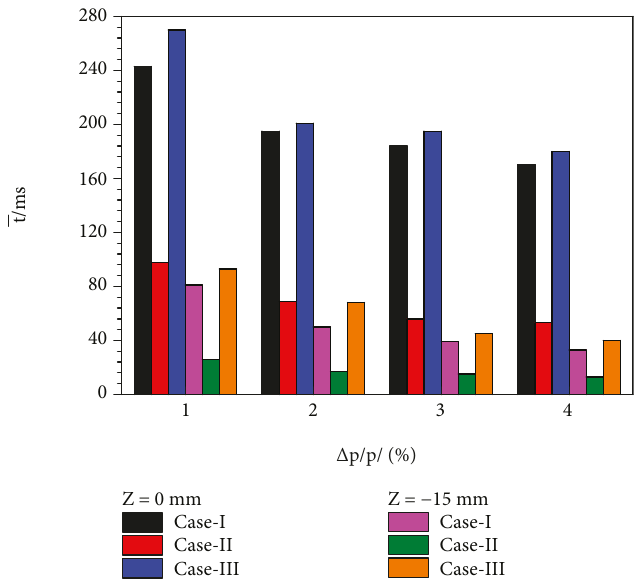
Figure 11: Residence time for the quenching zone on the Z = 0mm plane and Z = − 15 5mm plane.